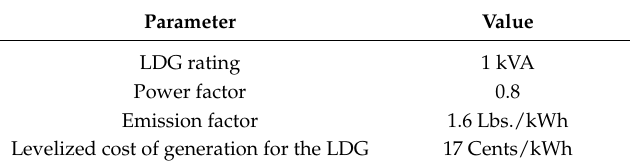
Table 9. Load shedding-compensating dispatchable generator